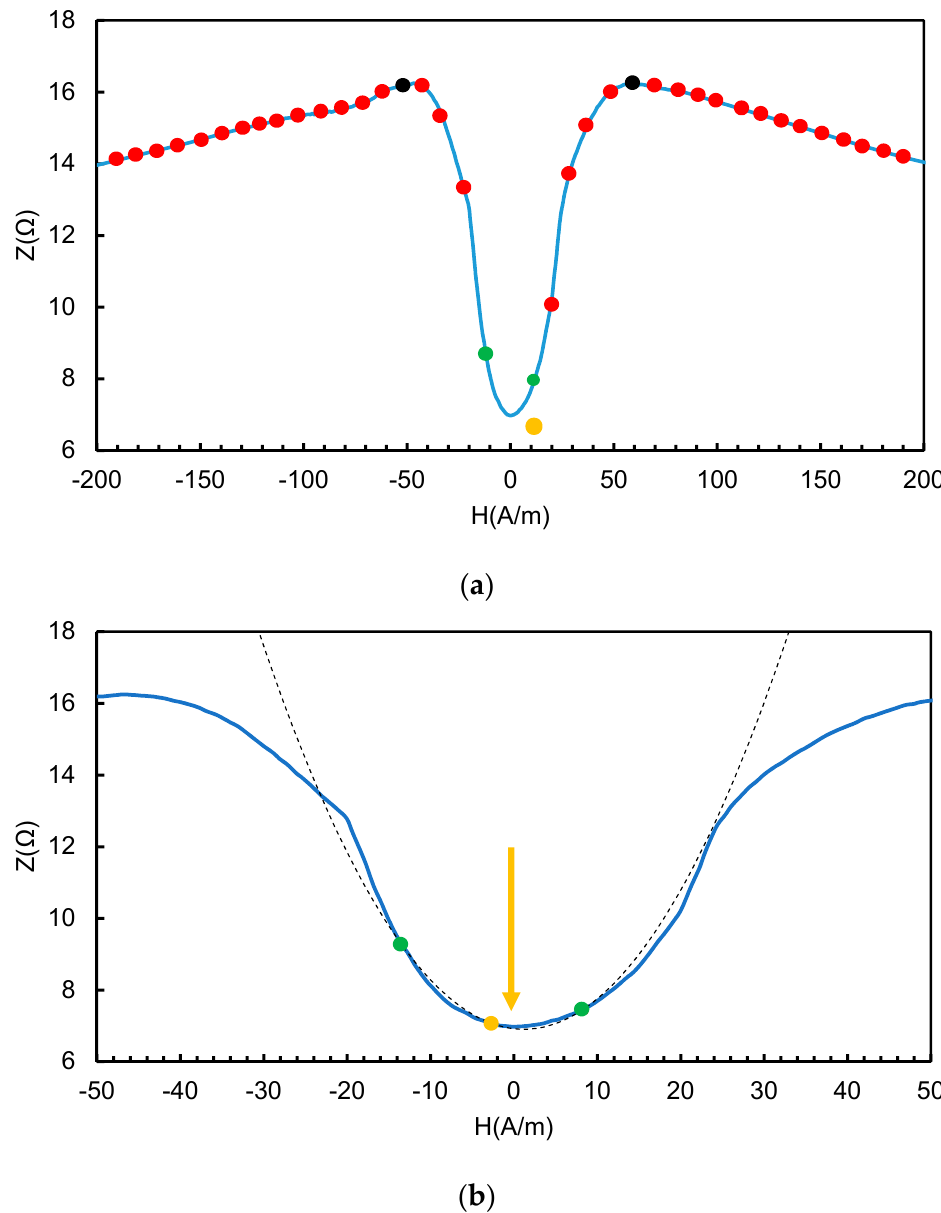
Figure 7. Principle of operation of the proposed sensor: ( a ) Stage I—the measurement of characteristic points, ( b ) Stage II—interpolation of the second-degree curve and compensation of the influence of the external field in order to obtain an indication of the minimum impedance (quasi-Newtonian optimization [51]).